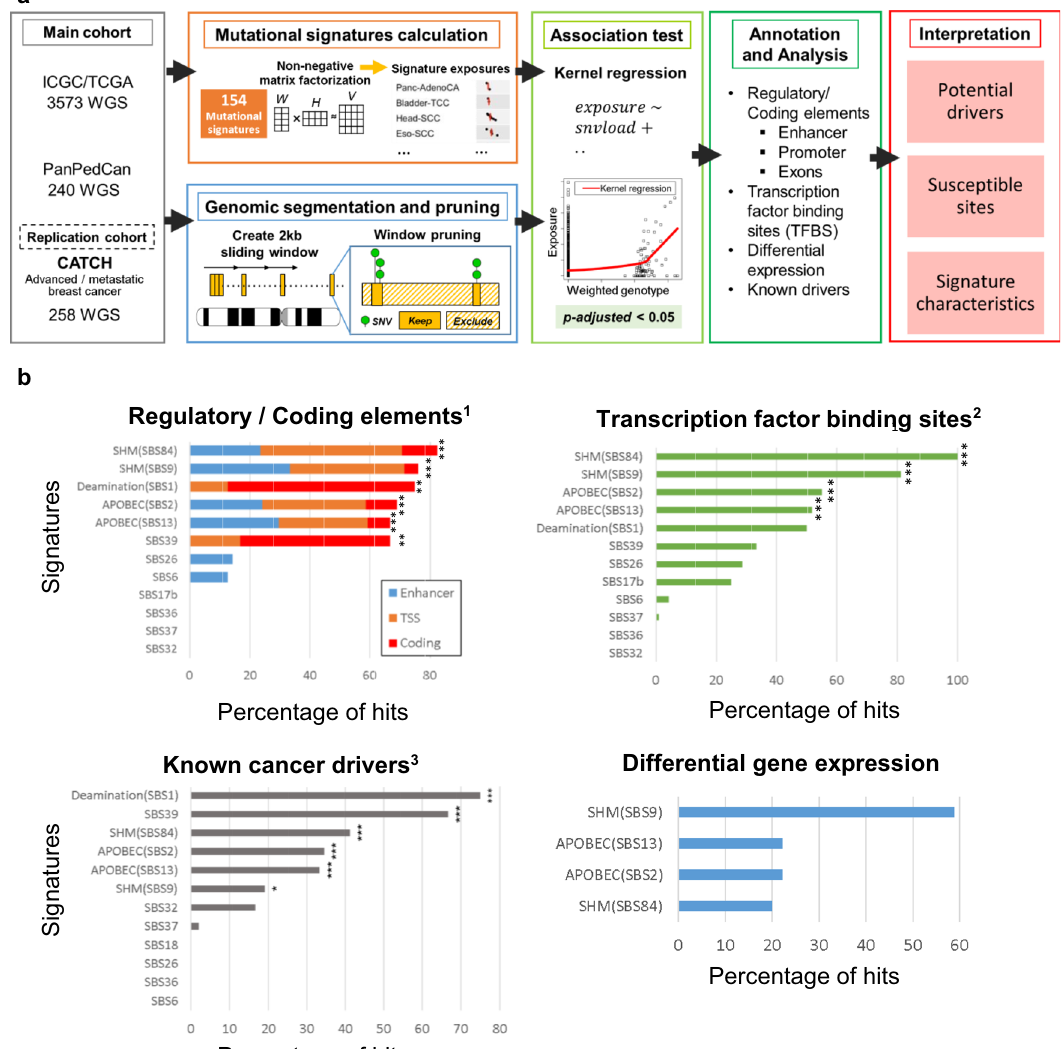
Fig. 1 Association analysis reveals hotspots associated with mutational signatures. a A fl ow chart on driver discovery using hotspot-signature association on the basis of 3813 whole-genome sequenced tumors and replication using 258 whole-genome sequenced breast tumors. b Associated hotspots per mutational signature were annotated by coding regions, regulatory elements (enhancers and transcription start sites, TSS), transcription factor binding sites, known cancer drivers and gene expression changes. Enrichment tests were performed on coding elements and regulatory elements together by permutation. Hotspots enrichment on transcription factor binding sites and known drivers were performed by two-sided hypergeometric tests. Signature-set wise correction of p values was performed by false discovery rate (Benjamini-Hochberg, Supplementary Data 4). The signi fi cance level indicated by *** and ** are q < 0.001 and q < 0.01 respectively. Source data are provided as a Source Data fi